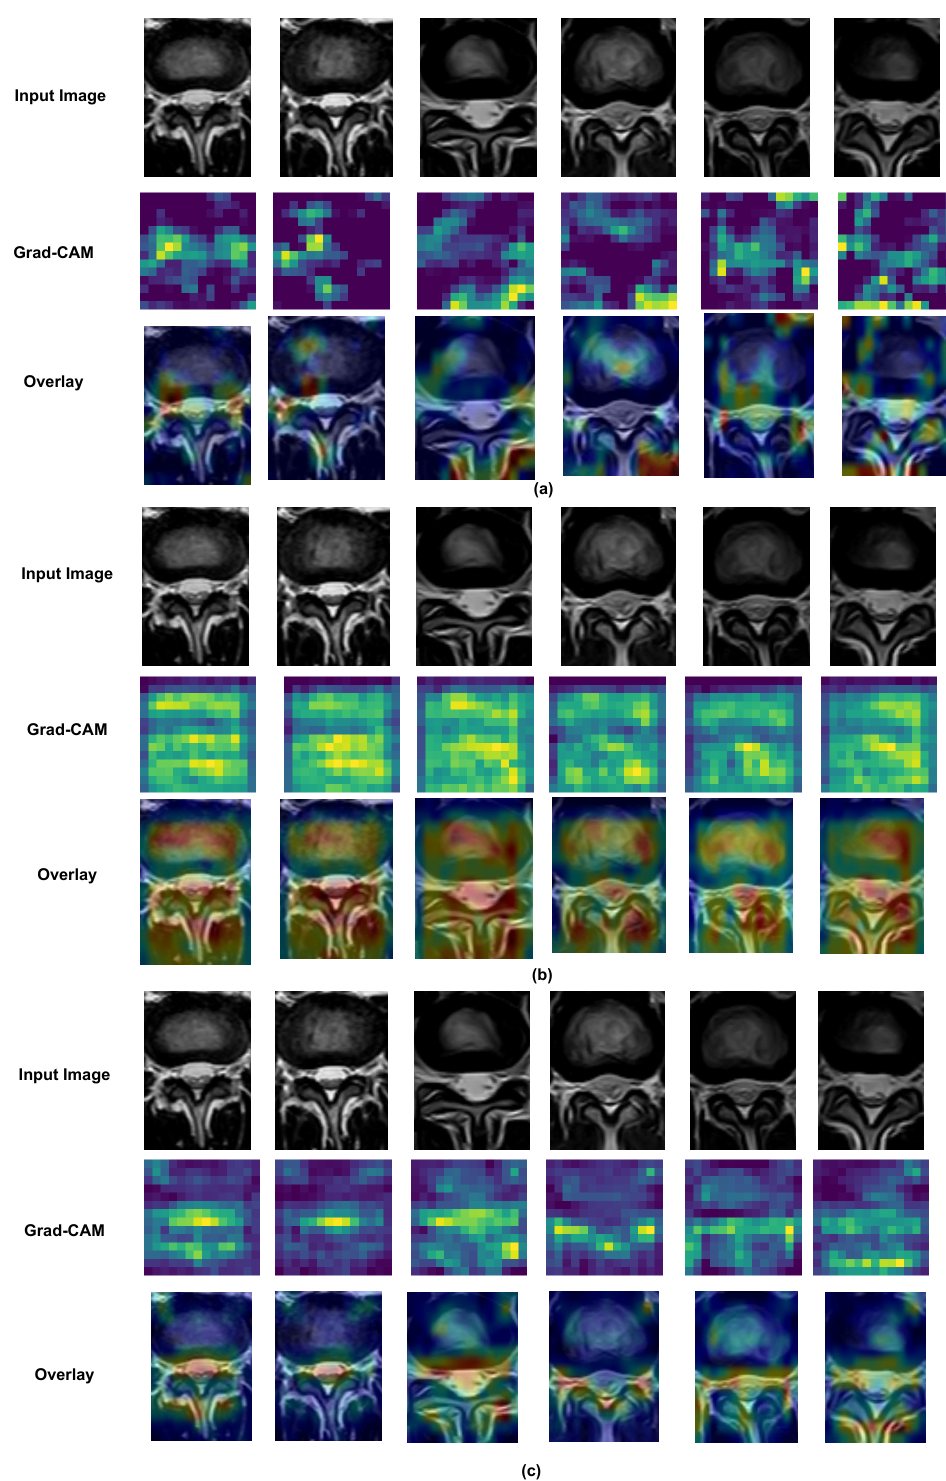
Figure 18. Grad-CAM visualization of features using VGG19 for disc state classification TL from ( a ) ImageNet, ( b ) labeled data (Dataset A), ( c ) unlabeled data(Dataset